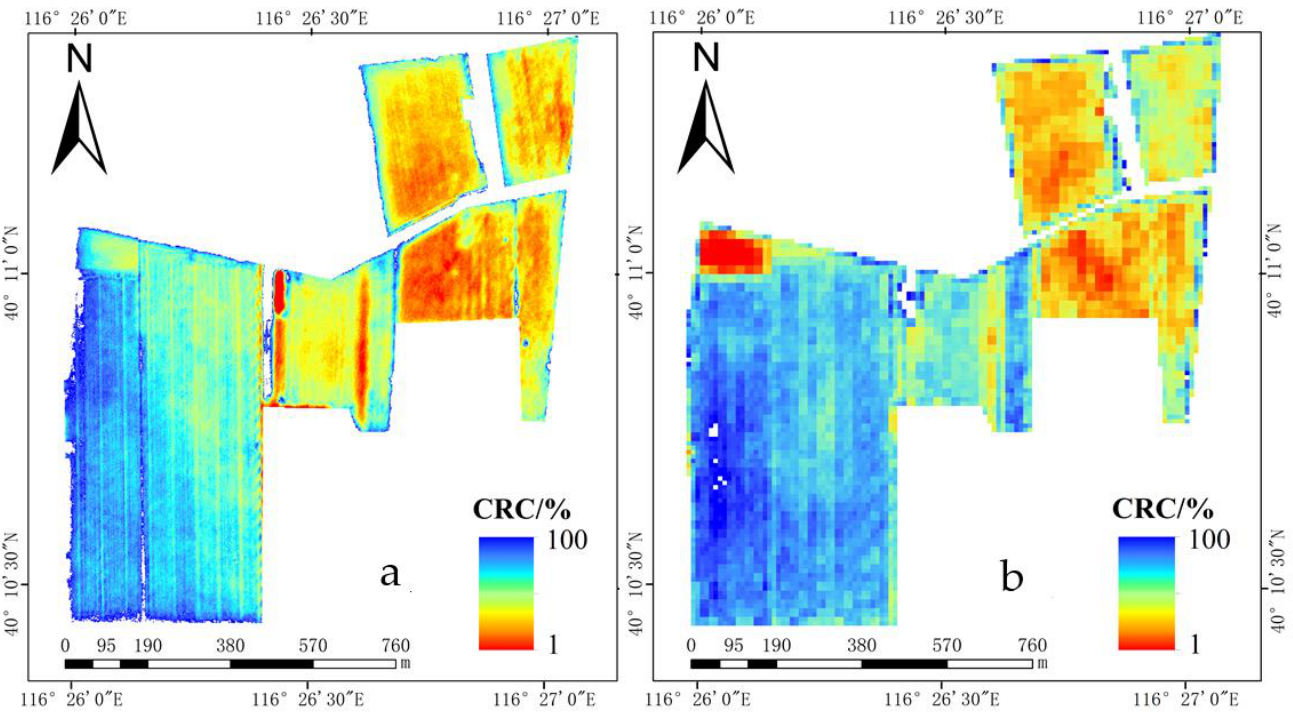
Figure 12. Estimation of wheat CRC (( a ) based on GF-1 data of the CRC RF -LASSO model; ( b ) based on S2 data of the CRC RF -DFI model).